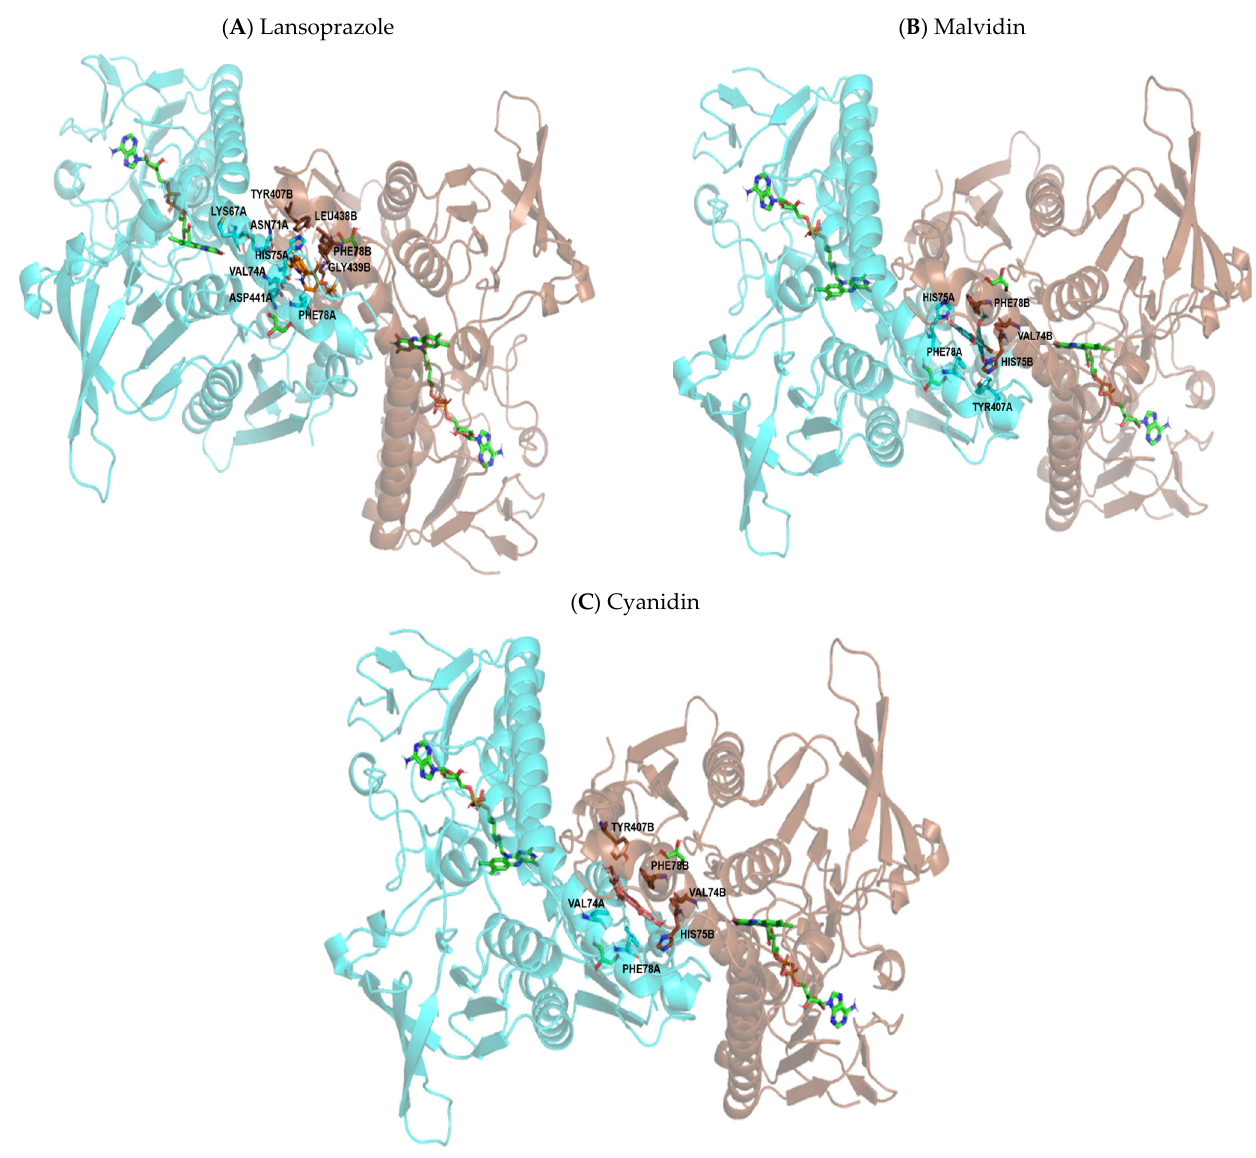
Figure 13. Molecular coupling of the lansoprazole ( A ), malvidin ( B ) and cyanidin ( C ) molecules in Glutathione reduced (GSH) protein structure–PDB 3SQP, docking in chain A and B. ( A ) Lansoprazole : Best pose with − 9.0 kcal/mol (affinity energy). FAD and glycerol molecules shown colored in green. Lansoprazole molecule colored in orange. ( B ) Malvidin : Best pose with − 8.5 kcal/mol (affinity energy). FAD and glycerol molecules shown colored in green. Malvidin molecule colored in bluish- green. ( C ) Cyanidin: Best pose with − 8.9 kcal/mol (affinity energy). FAD and glycerol molecules shown colored in green. Cyanidin molecule colored in pink.